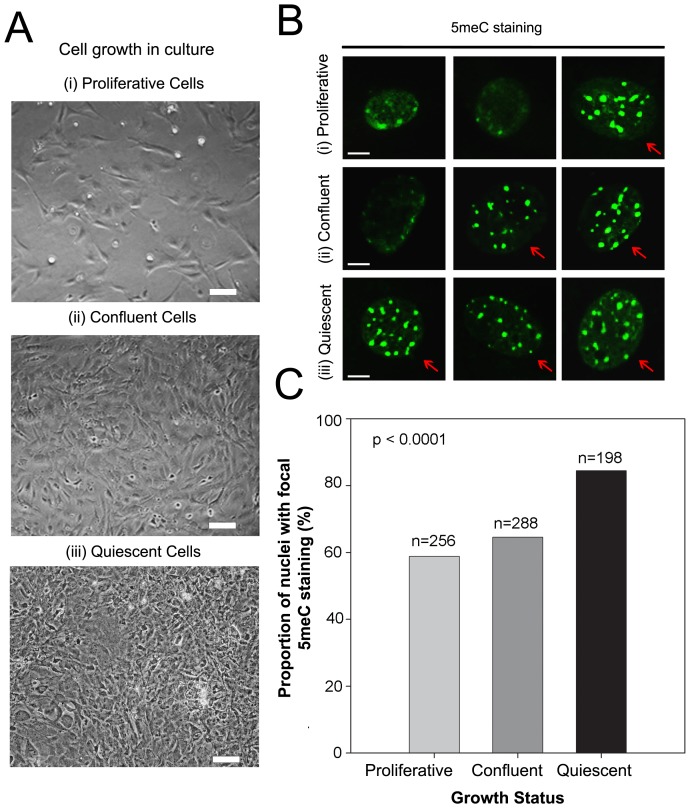
The staining pattern of 5meC within nuclei in MEFs.
A Phase contrast images of the growth pattern of MEFs in (i) sparse (proliferative), (ii) confluent, and (iii) serum deprived confluent (quiescent) cells. Bar = 20 µm. B Typical examples of the 5meC staining patterns of MEFs in (i) proliferative, (ii) confluent, and (iii) quiescent growth phases. Arrows show cells with a predominantly focal pattern of staining and the other cells show a predominantly diffuse pattern of staining. Scale bar 5 µm. C The proportion (%) of nuclei with predominantly focal 5meC staining in each cell (n, number of nuclei analysed). The focal pattern of 5meC increased with cell proliferation (p<0.0001). The results are representative of three independent replicates. Epitope retrieval was by treatment with of cell with HCl 4N for 10 min at 22°C.